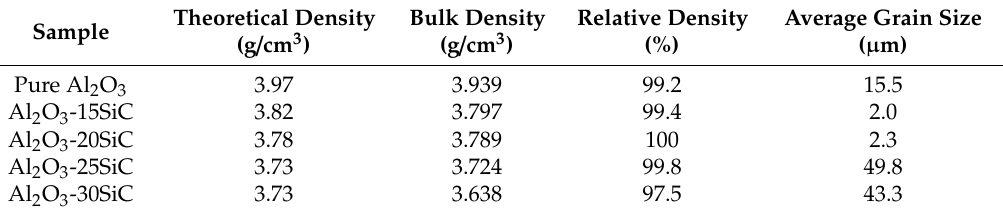
Table 3. Density and average grain size results of the sintered samples.